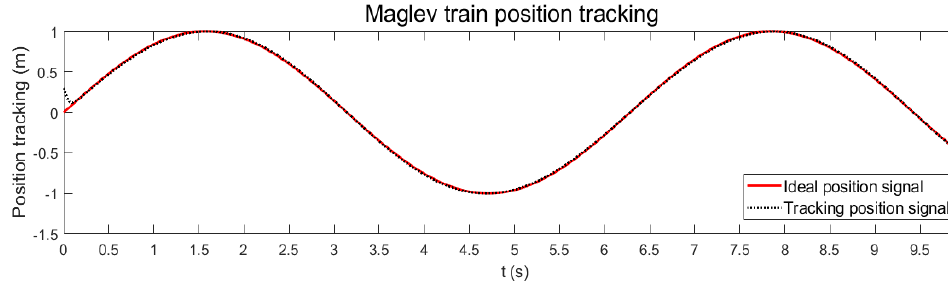
Figure 6. Maglev train displacement tracking curve.